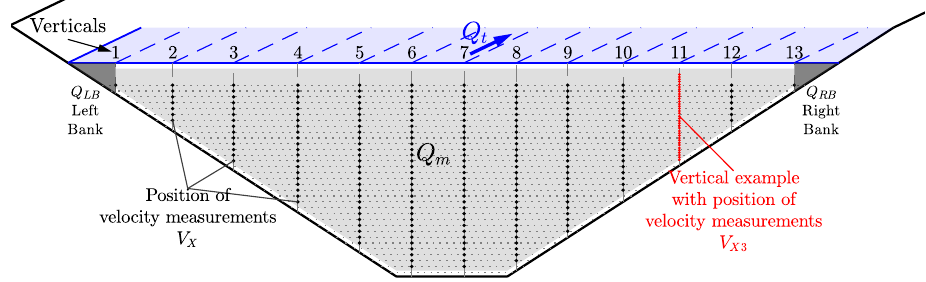
Figure 2. Example of measurement layout in GG7 with the ADCP Qliner